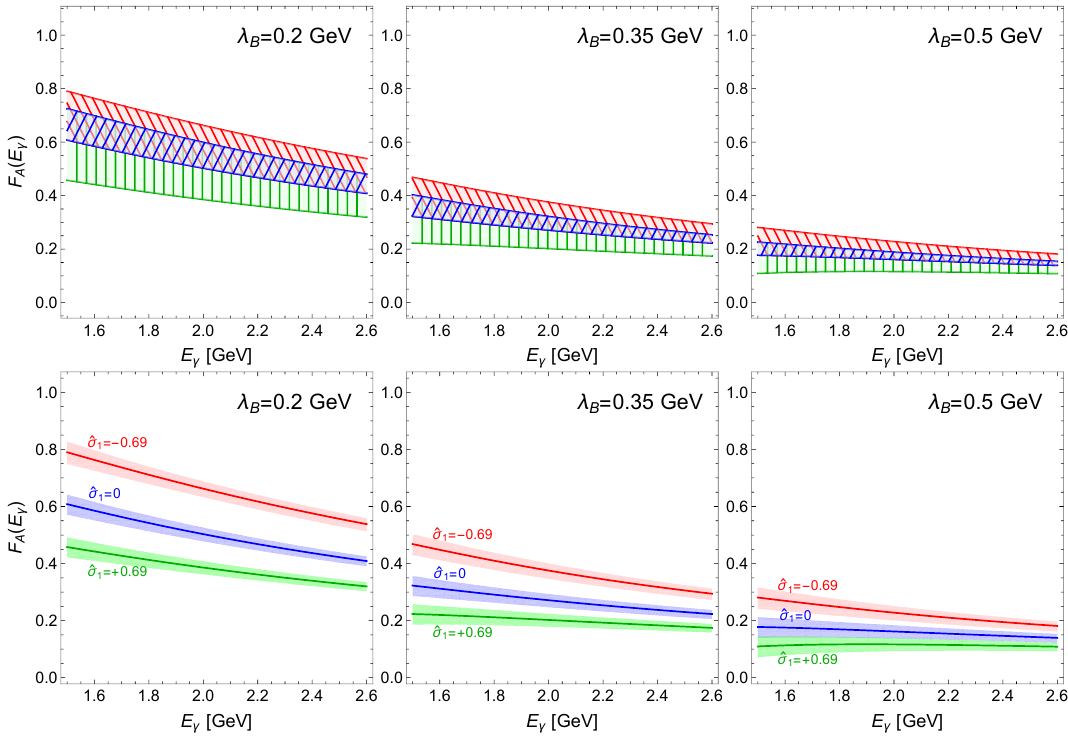
Figure 8 . Axial form factor F A ( E (cid:13) ). The legend follows (cid:12)gure 7. Our (cid:12)nal results for the vector F and axial F form factors are shown in (cid:12)gures 7 V A and 8, respectively. 8 The shaded regions on the upper panels in both (cid:12)gures show the variation for a given model with the range of parameters speci(cid:12)ed in (5.3) and central values for other parameters. The colour coding follows (cid:12)gure 3. The uncertainty from variation of the other parameters in the range speci(cid:12)ed in table 1 is shown on the lower panels for three cases: (cid:27) = (cid:6) 0 : 69 corresponding to the boundaries of the three models’ 1 b envelope, and (cid:27) = 0. For the last value our three models coincide and reduce to the 1 b